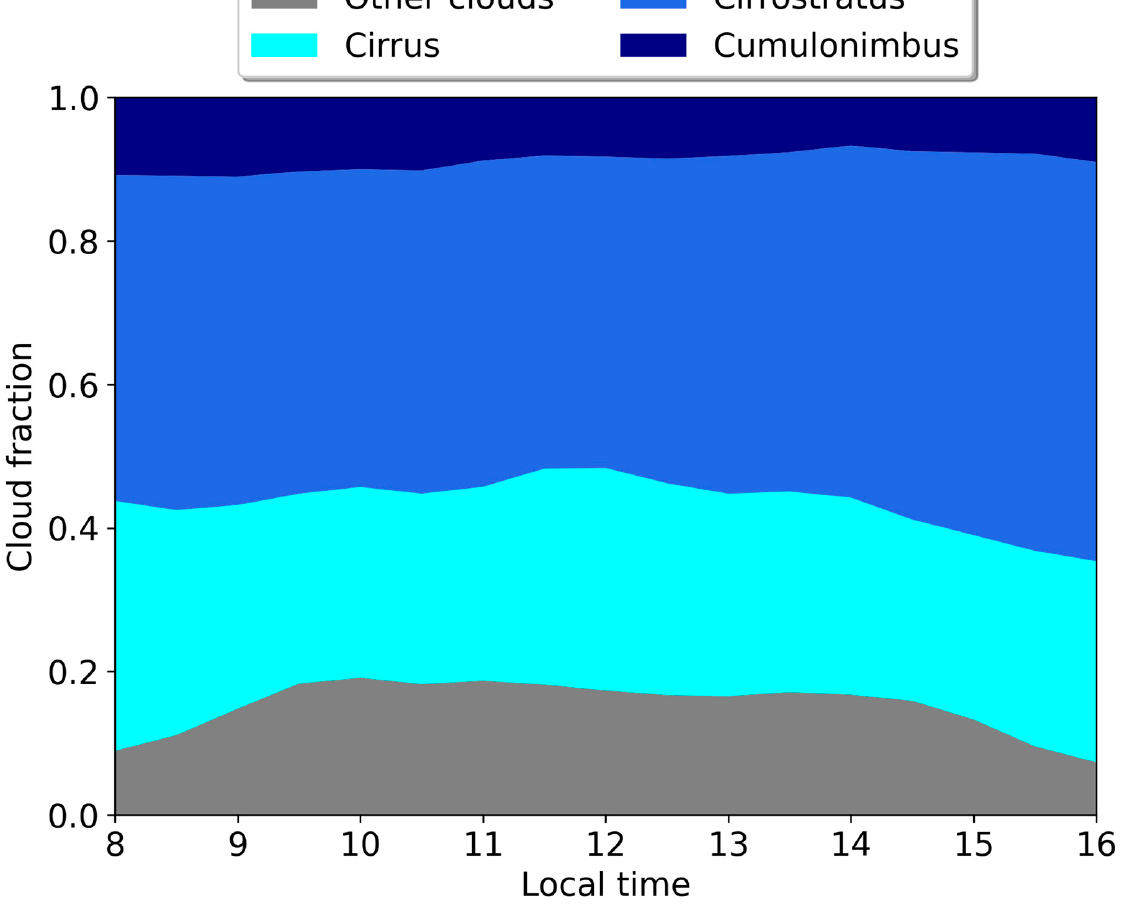
Figure 9. Cloud type fraction, based on ISCCP cloud classification criteria, using the COT retrievals from Case A, GOES-17 cloud phase and CTP products.